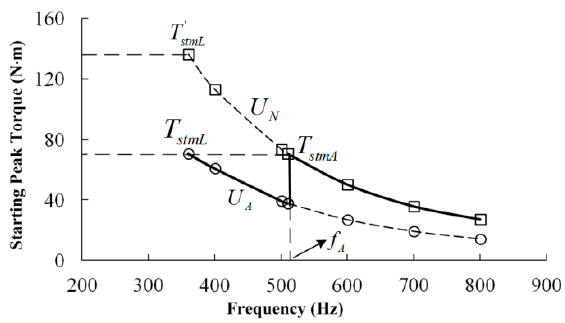
Figure 6. Starting peak torque with the low-frequency step-down starting.